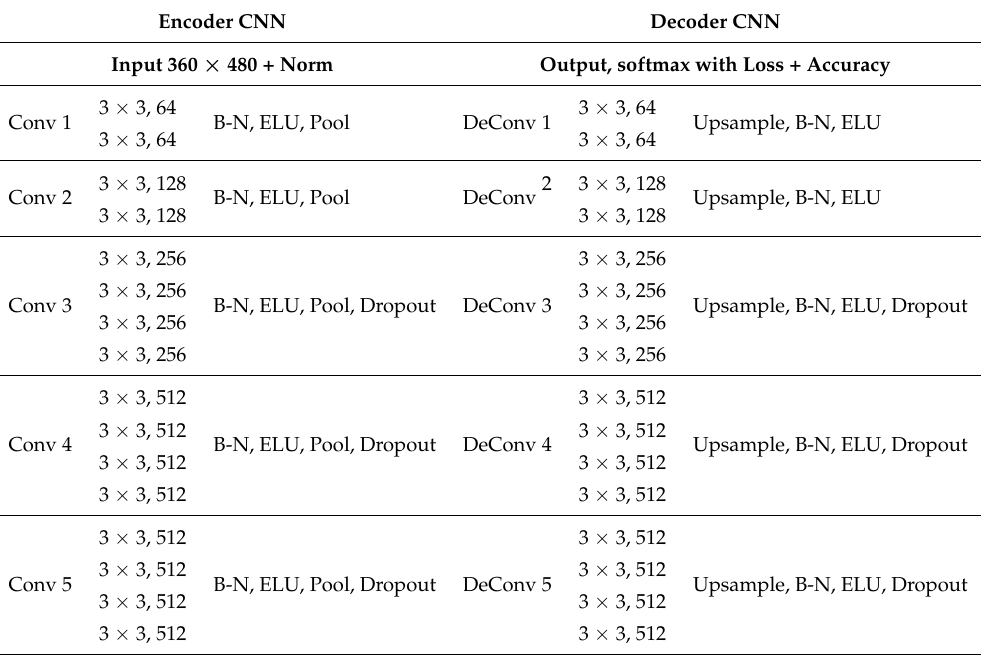
Table 2. ECRU’s encoder-decoder layer’s